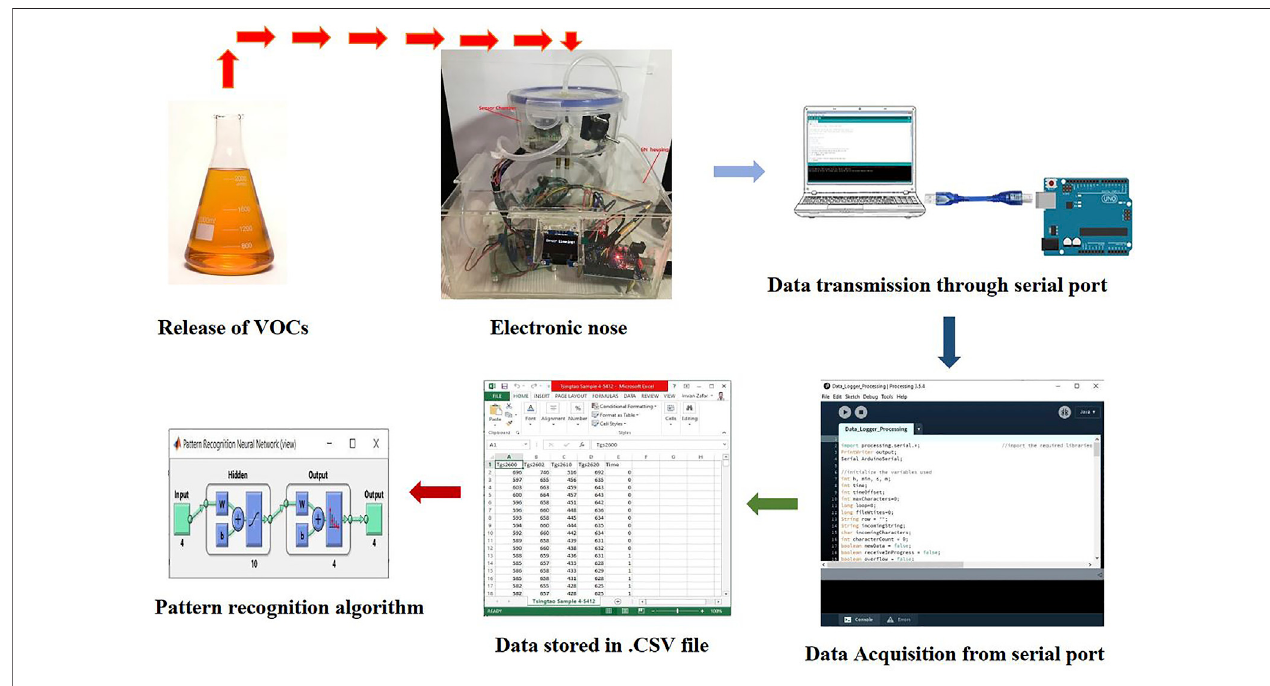
FIGURE 2 | Block diagram of data acquisition subsystem.